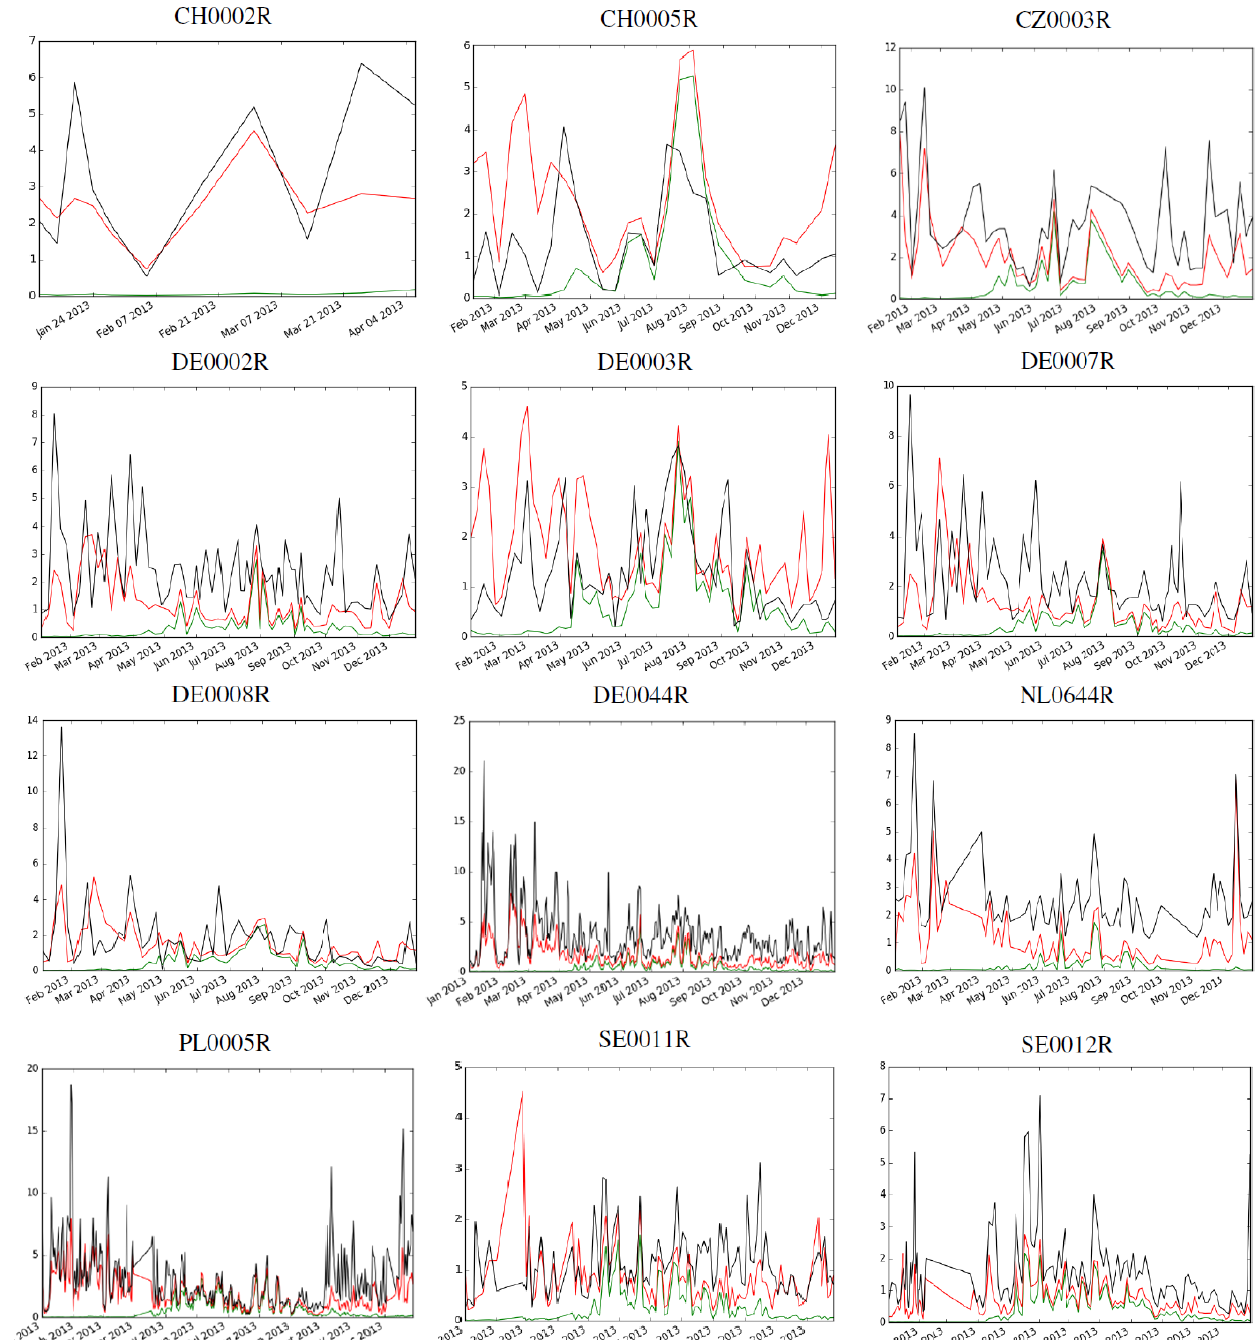
Figure 10. Temporal evolution of modeled (red line) and measured (black line) OC concentrations (in µgm − 3 ) for stations in the south of Europe. The green line corresponds to OC from biogenic